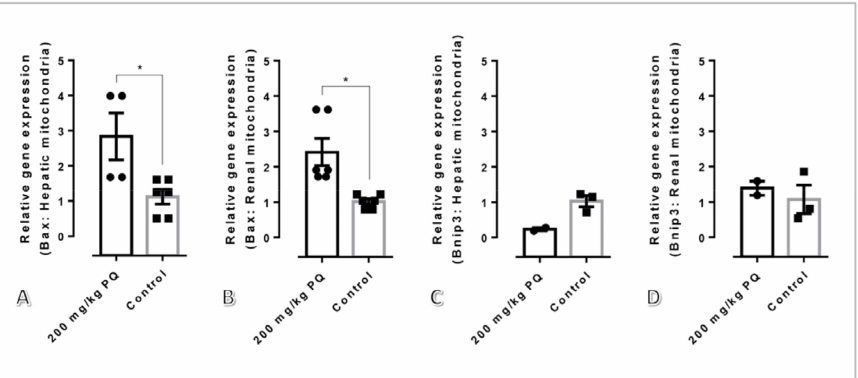
Figure 6. mRNA expression of pro-apoptotic related genes in renal and liver mitochondria af- ter treated with or without 200 mg/kg of PQ; mRNA level of Bax ( A , B ) and Bnip3 ( C , D ) in the hepatic ( A , C ) and renal ( B , D ) mitochondria, respectively. For subsequent figures, statistical signifi- cance of comparisons is *, p <